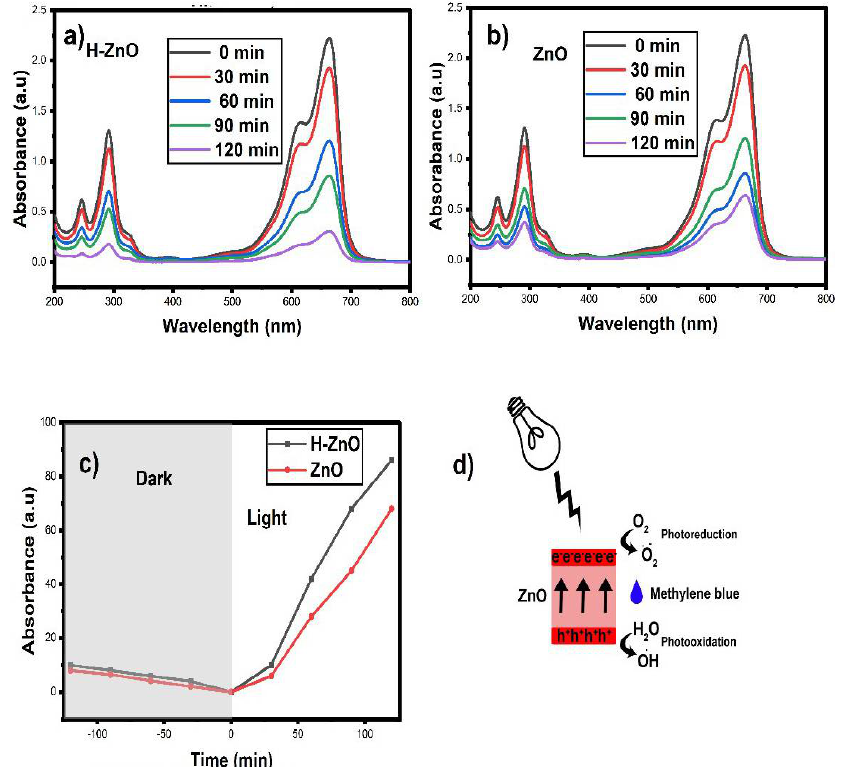
Figure 9. ( a ) Photocatalytic activity of H-ZnO; ( b ) of ZnO; ( c ) degradation efficiency and ( d ) mechanism of ZnO nanoparticles.